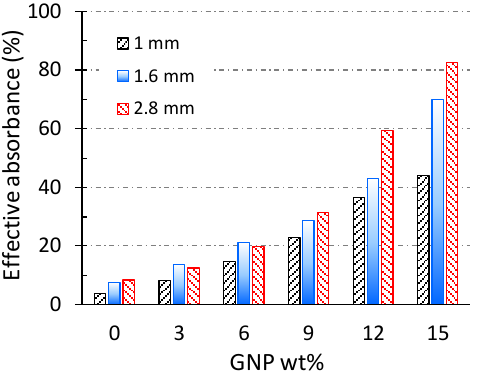
Figure 7. Effective absorbance of PBAT/GNP nanocomposites with different thicknesses as a function of GNP loading at mid X-band frequency (10 GHz).